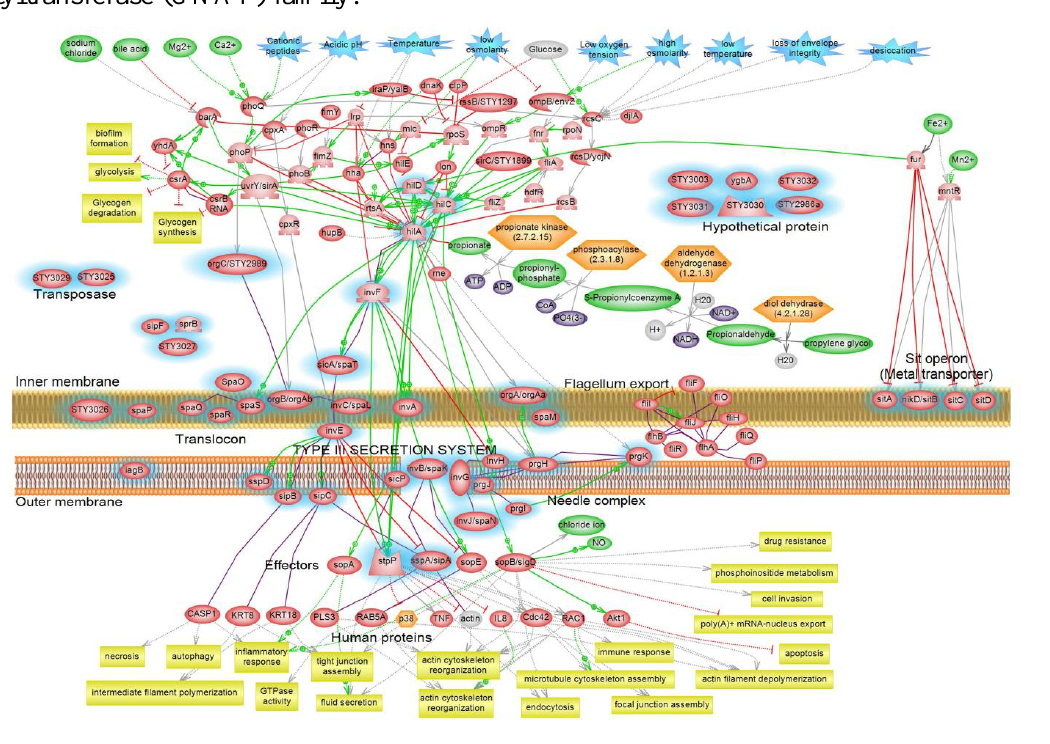
Figure 2: SPI-1 regulation pathway. Proteins encoded by SPI-1 are highlighted in blue. SPI-1 encodes for T3SS which is important for Salmonella invasion of the host cell. The central regulator of SPI-1 expression is HilA transcription factor. A detailed view of the SPI-1 pathway including supporting literature is available at http://www.ccbusm.com/publications/spi/SPI-